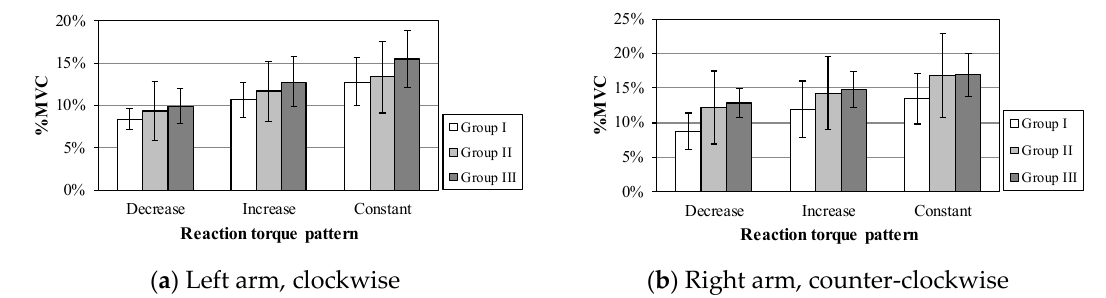
Figure 9. Results of sensibility EMG measurement.